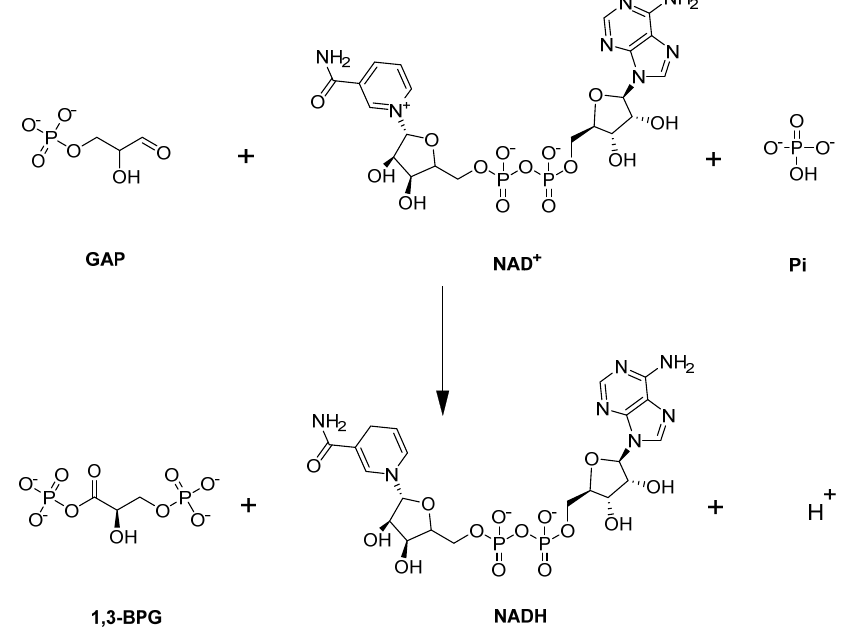
Figure 7. GAPDH-catalyzed reaction. GAPDH functions by mediating O 2 -dependent metabolic variation through its facil- itation of the binding of metabolic enzymes and deoxyHb to the N-terminal cytosolic do- main of band 3 [12]. Normally, GAPDH is inactivated when bound to band 3 but becomes activated once it is released to the cytosol [12]. Under the RBC sickling condition, deoxy- HbS forms a ternary complex with 2,3-BPG and S1P and binds with a high affinity to band 3, thereby displacing GAPDH into the cytosol, leading to an increased activity and conse- quent metabolic shift from PPP to glycolysis (Figure 8; [12]). Unfortunately, the increase in glycolysis results in a detrimental cycle in which 2,3-BPG levels are elevated, leading to an increased concentration of deoxyHbS and, thus, more RBC sickling. In turn, this causes a decrease in antioxidant production, making the cells unable to detoxify the reactive ox- ygen species and, ultimately, leading to RBC hemolysis and oxidative stress. It is worth noting that GAPDH is naturally inhibited by S-glutathionylation, which is severely re- duced in SCD [83,84]. Therefore, the inhibition of GAPDH activity could potentially inter- rupt this cycle, as a therapeutic strategy to ameliorate SCD.